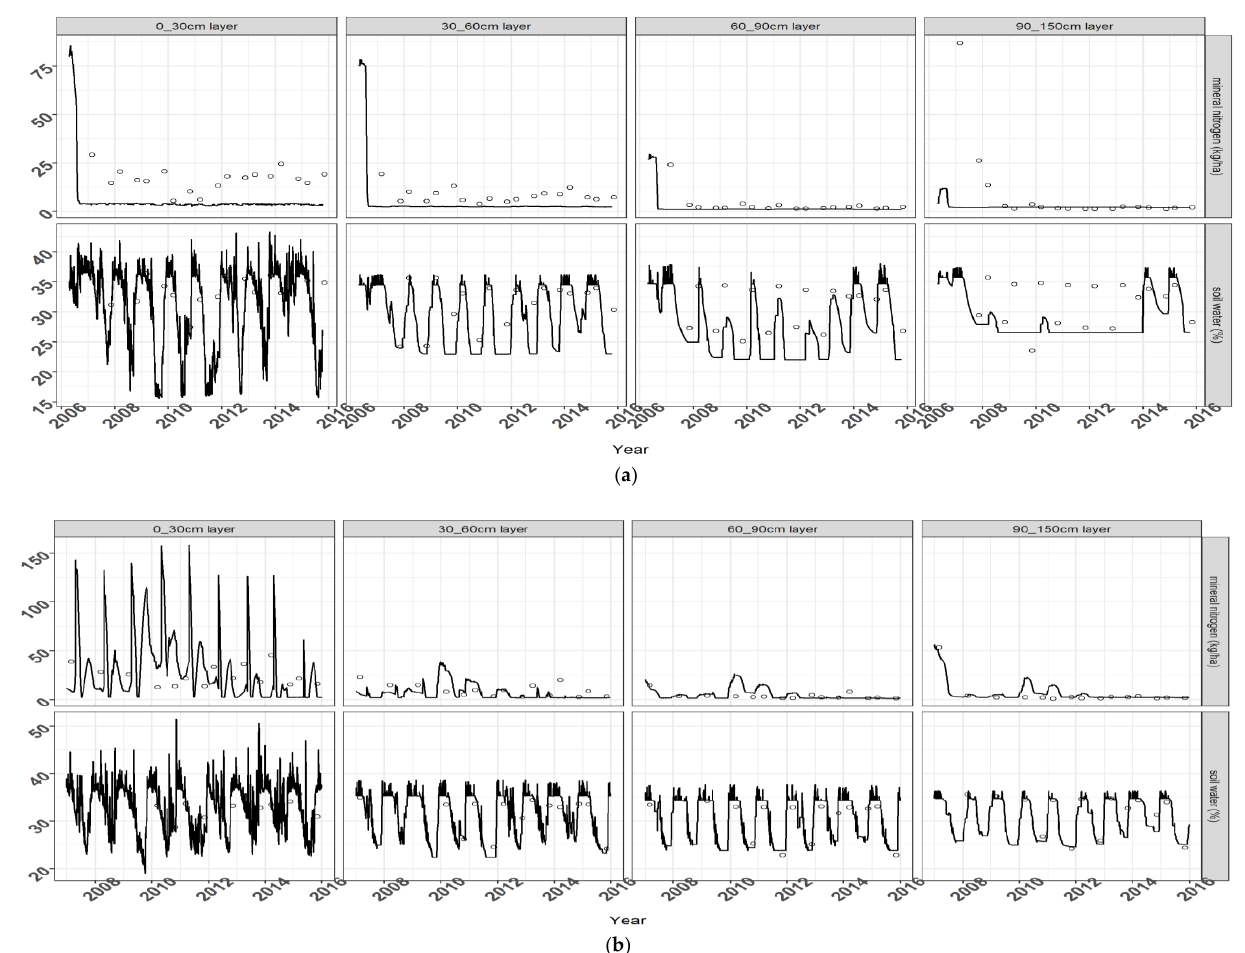
Figure 4. Soil mineral nitrogen (top) and soil water (bottom) dynamics for miscanthus early harvest without fertilization ( a ) and switchgrass late harvest with fertilization ( b ) in Estrée-Mons (the label of the y axis is indicated on the right hand side of the graphs).